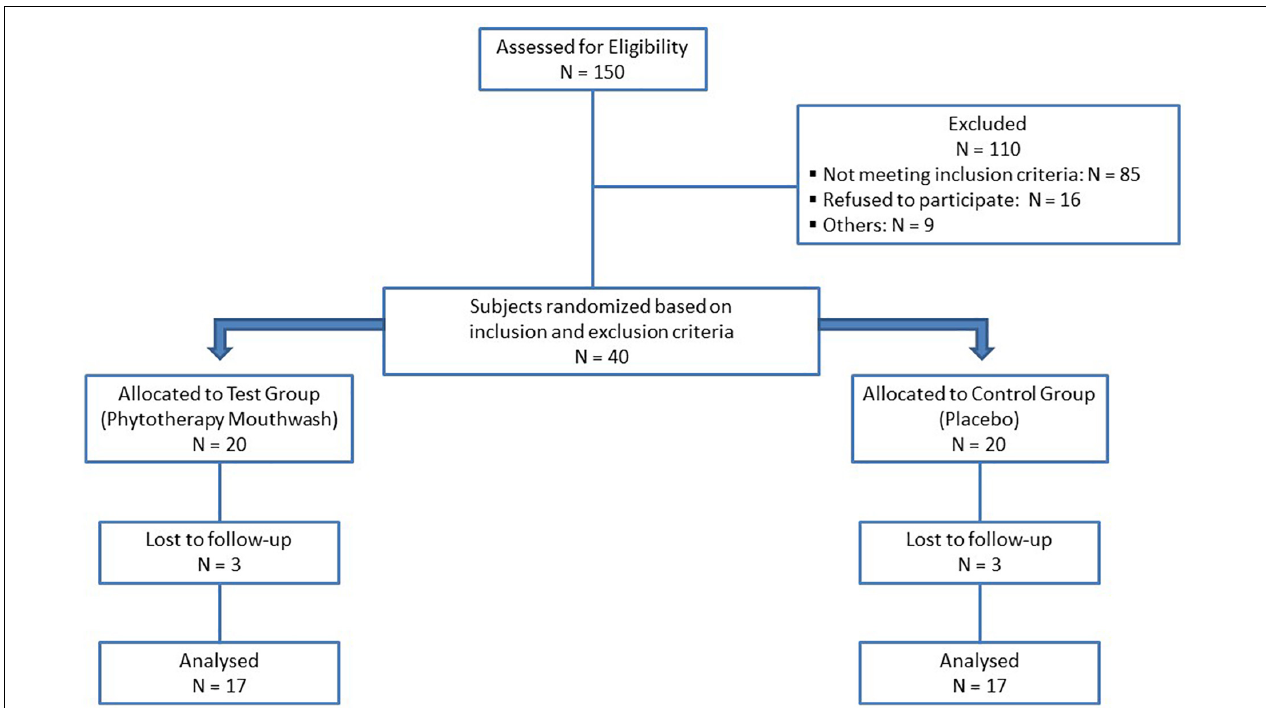
FIGURE 1 | CONSORT flow chart. N: Number of